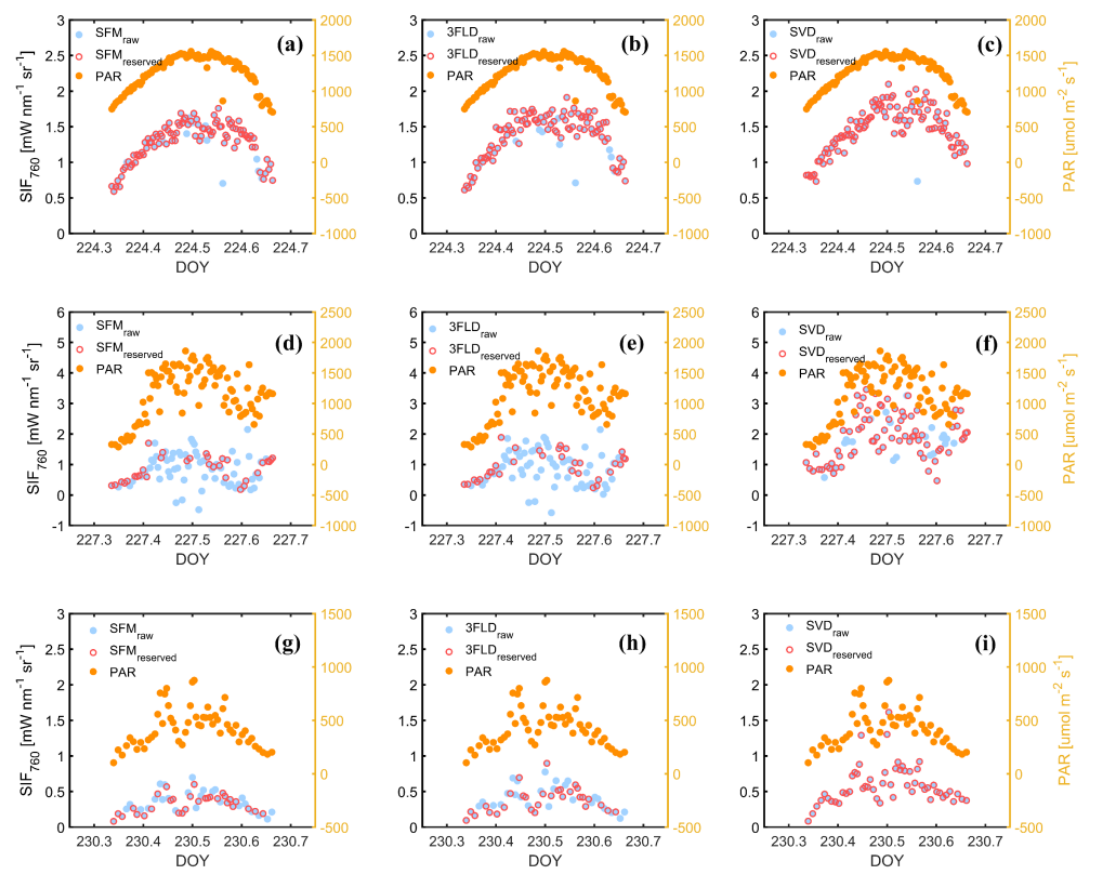
Figure 6. The diurnal dynamics of SIF retrieved by the SFM, 3FLD, and SVD methods and the diurnal dynamics of PAR under different sky conditions, such as ( a – c ) for the clear day (DOY 224); ( d – f ) for the rapidly fluctuating illumination condition day (DOY 227); and ( g – i ) for the cloudy day (DOY 230). The blue dots represent the retrieved SIF at 760 nm by the three algorithms. The red circles represent the reserved SIF. The orange dots illustrate the average values of the high–frequency PAR data during the L measurements.